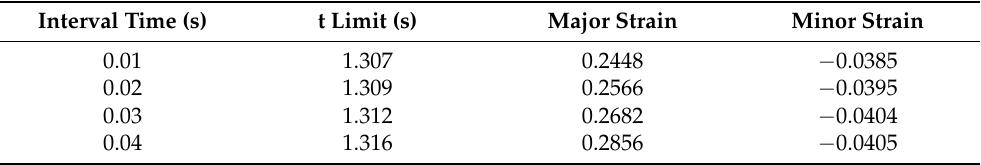
Table 2. Different interval times with corresponding forming limit values.